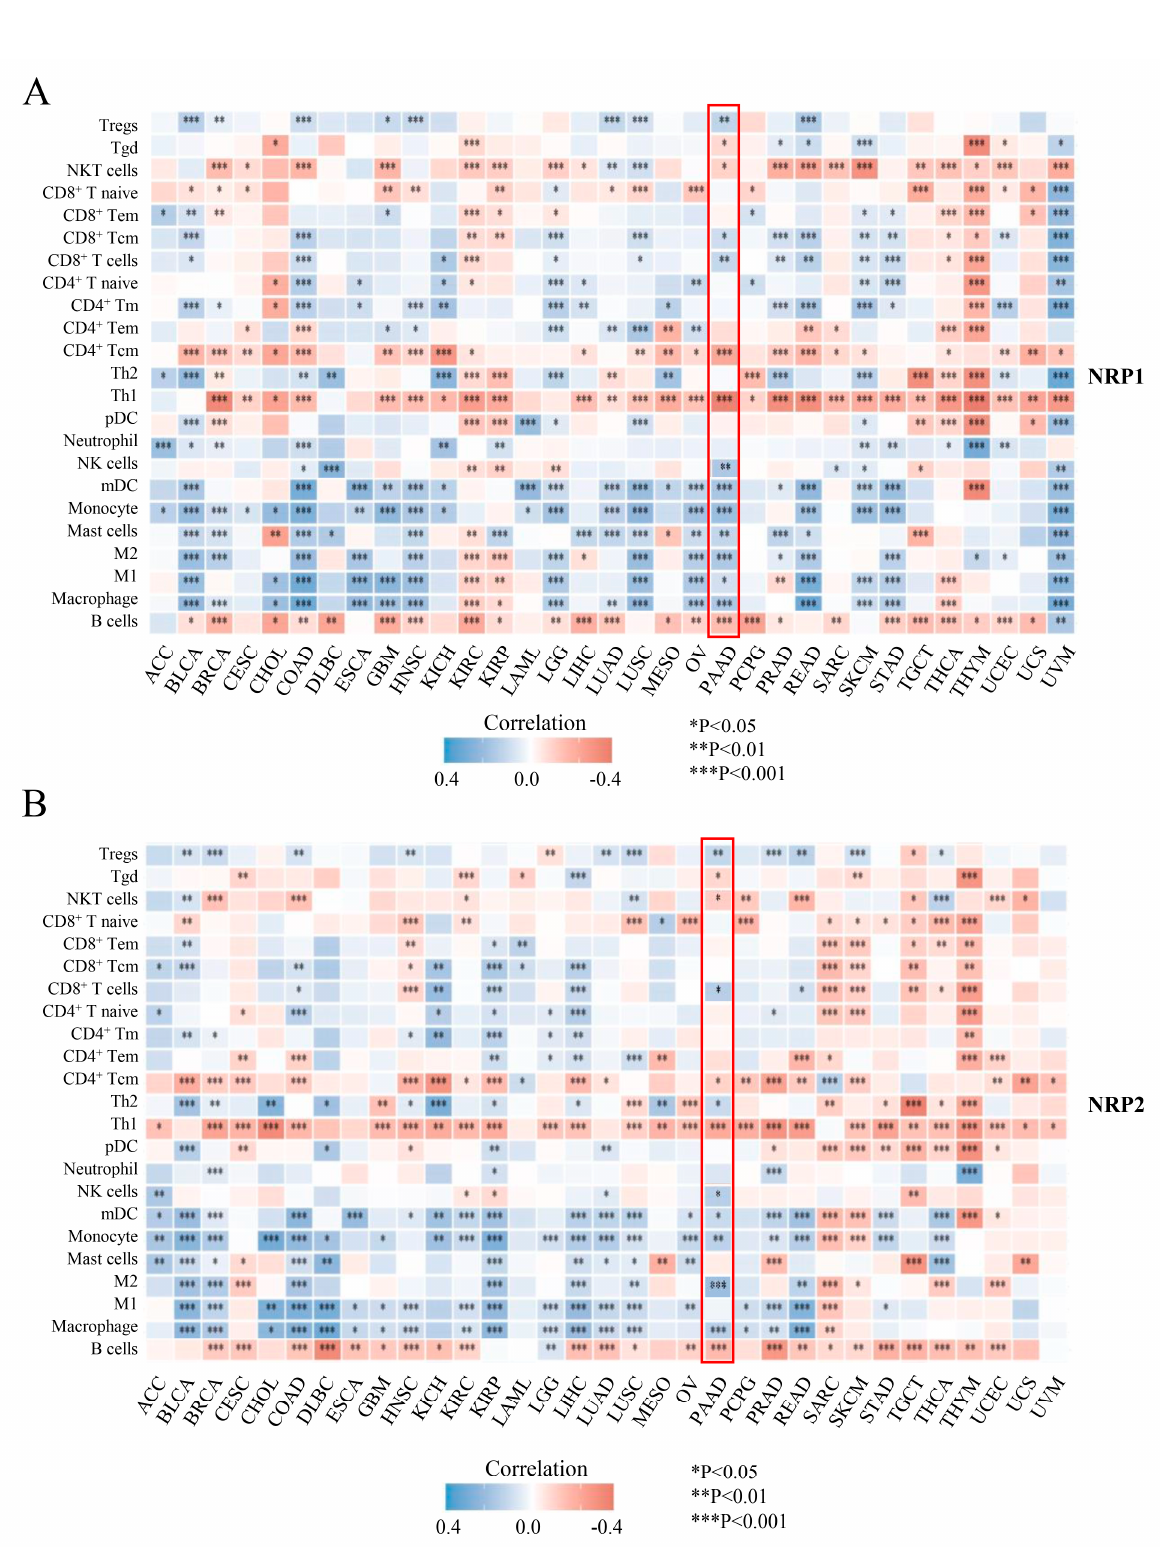
Figure 4. Tumor-immunology analysis. The correlation between NRP1 ( A ), as well as NRP2 ( B ), and the immune cell infiltration level using ssGSEA. The results of the PAAD are highlighted in the “red box”. * p < 0.05; ** p < 0.01 and *** p < 0.001.